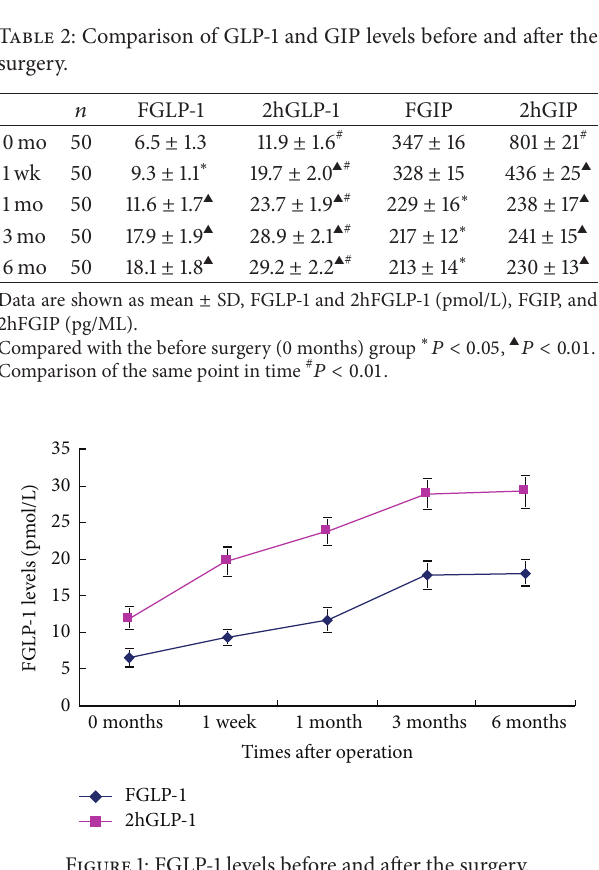
Figure 1: FGLP-1 levels before and after the